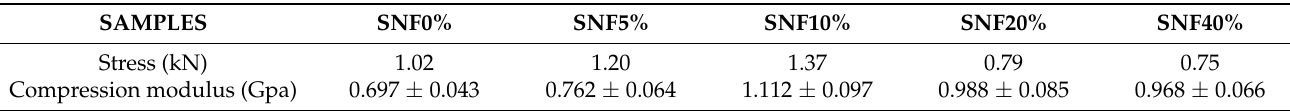
Table 1. Mechanical properties of different silk